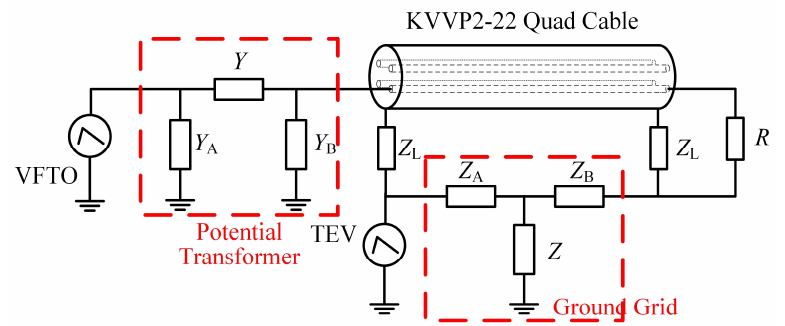
Figure 10. Schematic diagram of conduction disturbance simulation calculation.